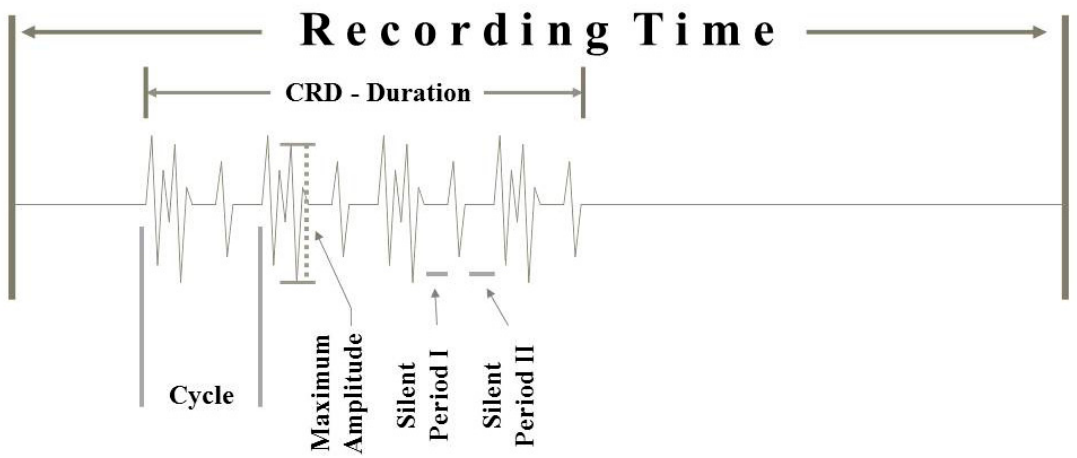
Figure 2. Schematic draft of a CRD recording showing the main CRD features that have been evaluated.